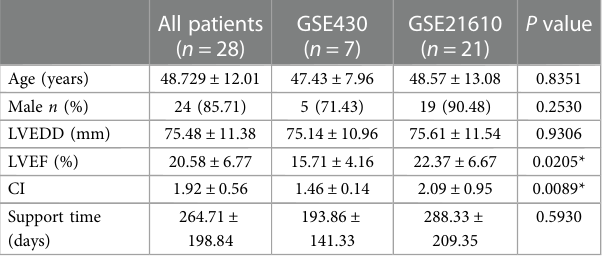
TABLE 3 Characteristics of clinical data of patients with